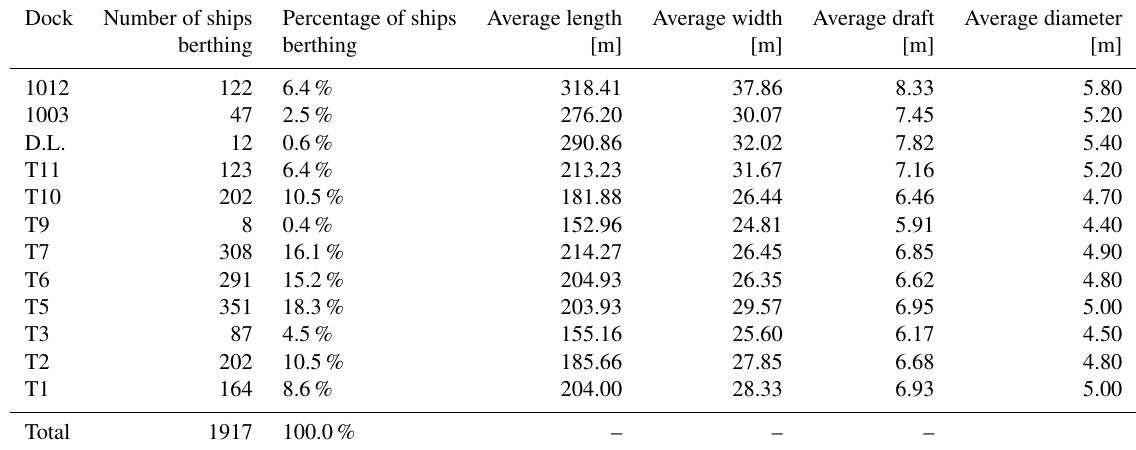
Table 1. Analysis of ship traffic in the port of Genoa for the year 2017 and the main characteristics of the ships representative of each dock. The ships’ length, width, draft, and propeller diameter values are expressed in